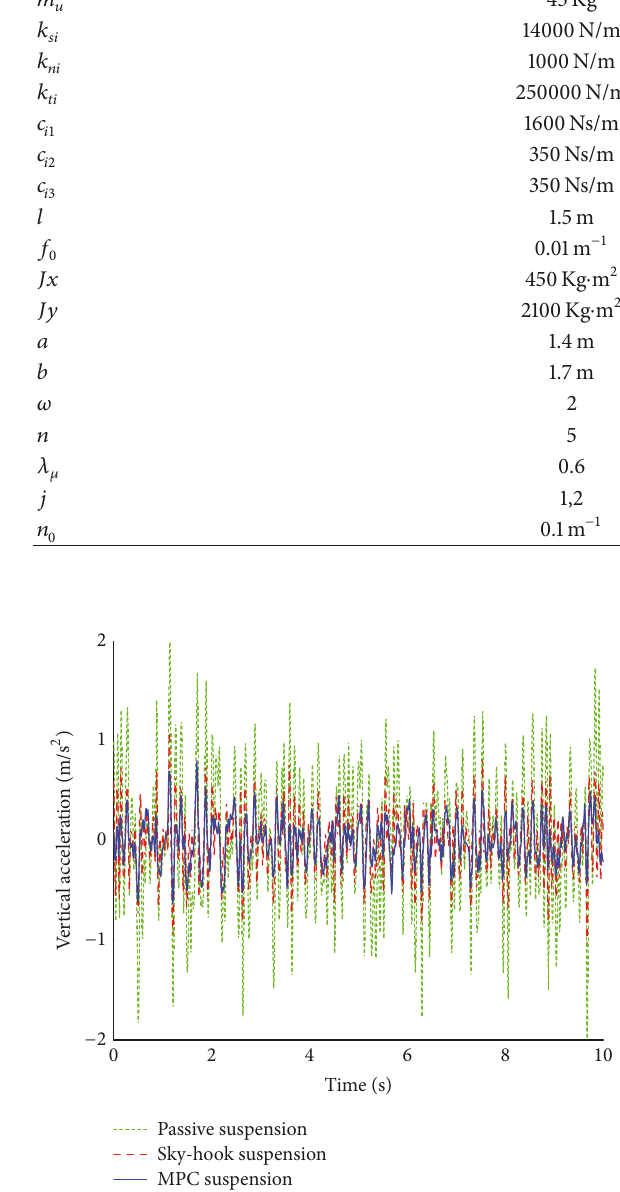
Figure 2: Vertical acceleration of car